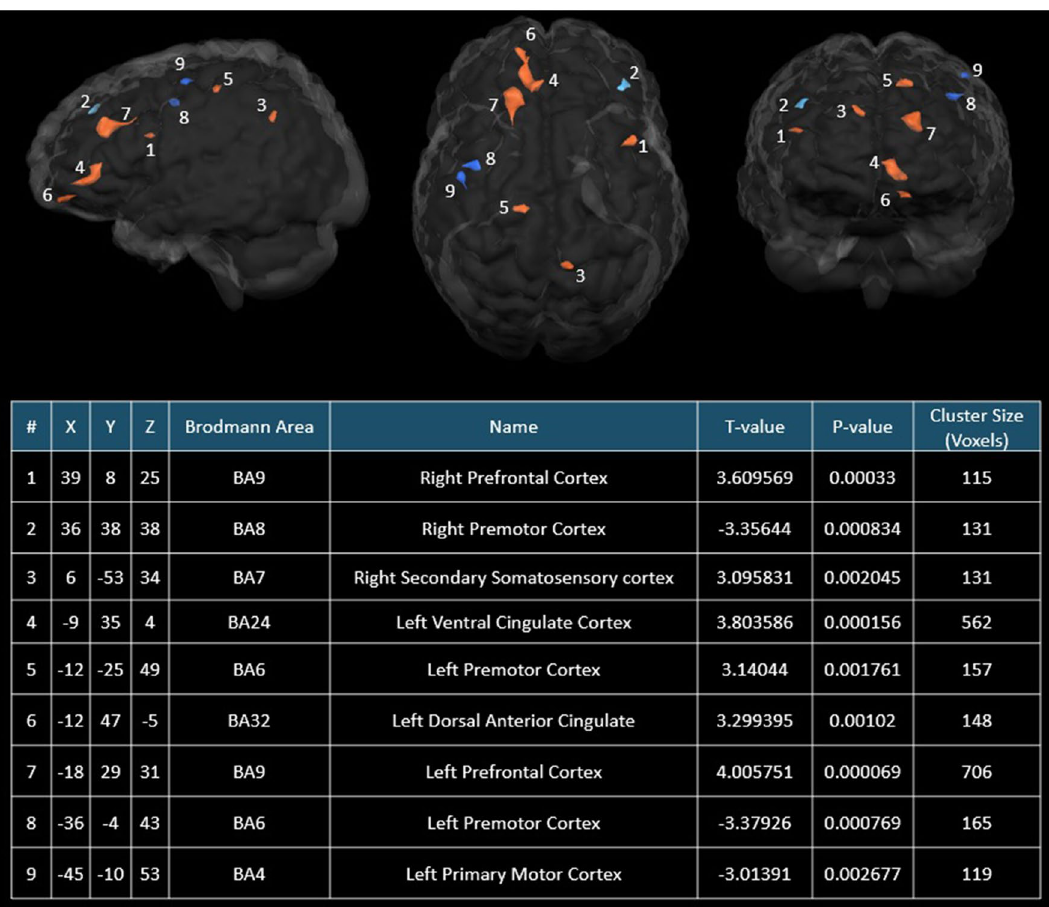
Figure 2. Real treatment related resting state functional connectivity differences with LPFC as the seeded modulatory function region. Regions in brown–red indicated significant ( P < 0.01; Cluster size > 100